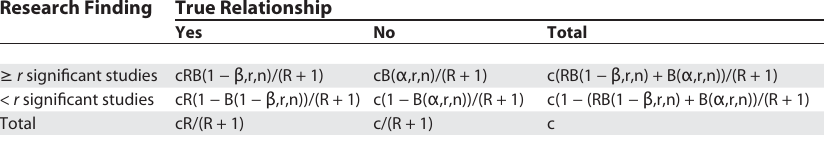
Table 1. Research Findings and True Relationships in the Presence of Multiple Studies Research Finding True Relationship Yes No Total